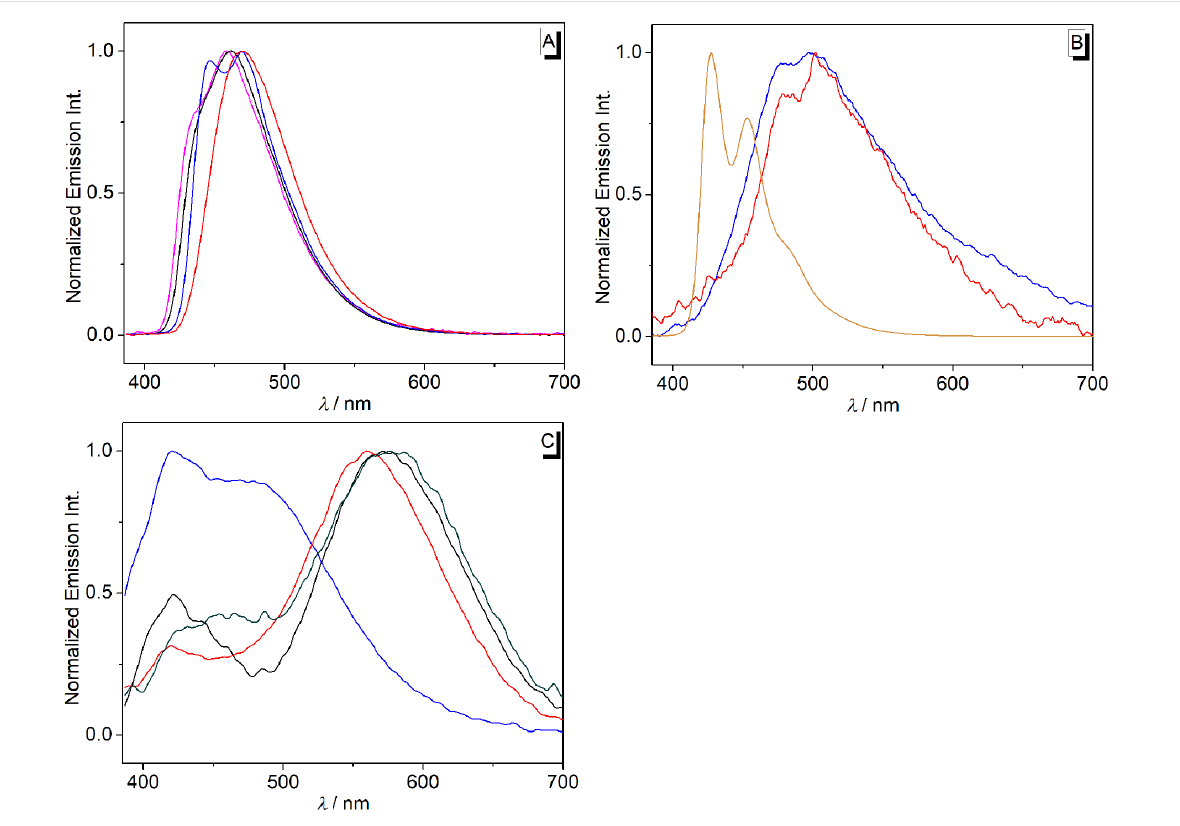
Figure 4: Emission spectra of derivatives 2a (A), 2c (B) and 2d (C); c = 20 μ M; λ ex = 375 nm; solvents: H 2 O (magenta), MeOH (black), CHCl 3 (blue), CH 2 Cl 2 (red), DMSO (green) and 1 N HCl (orange); λ ex = 375